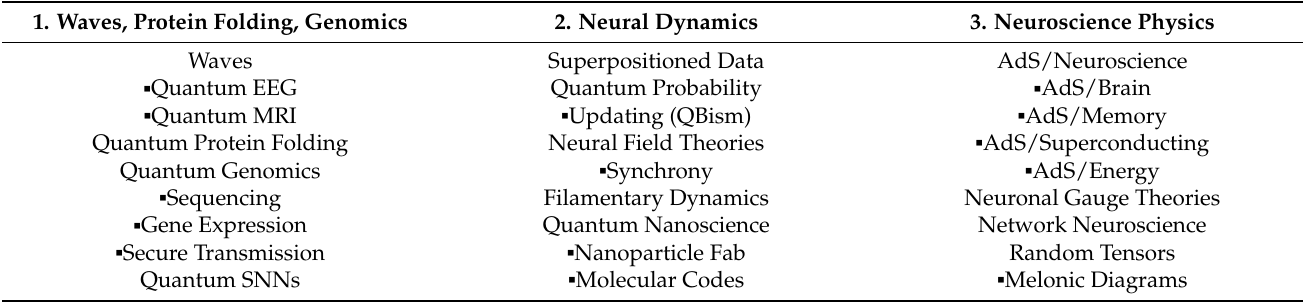
Table 2. Quantum neurobiology: three areas of quantum information science study.